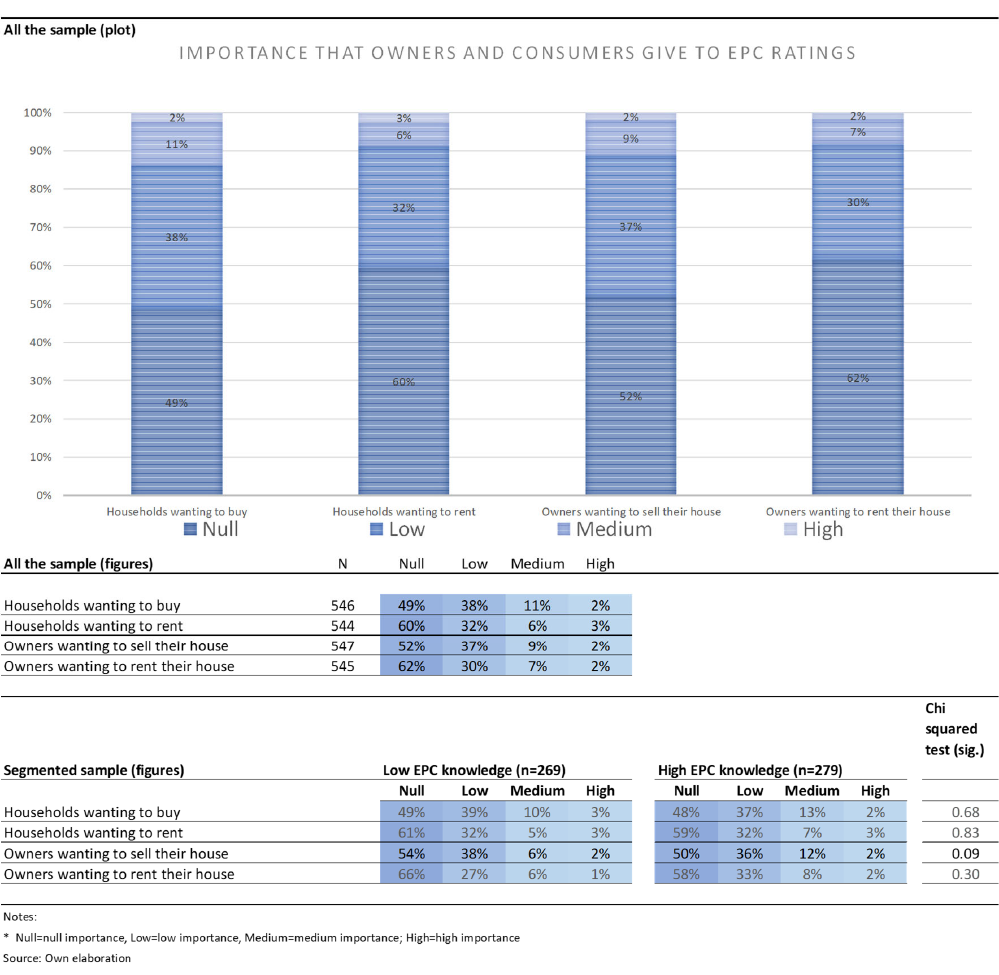
Figure 3. Perceived importance of EPC ratings for owners and users.